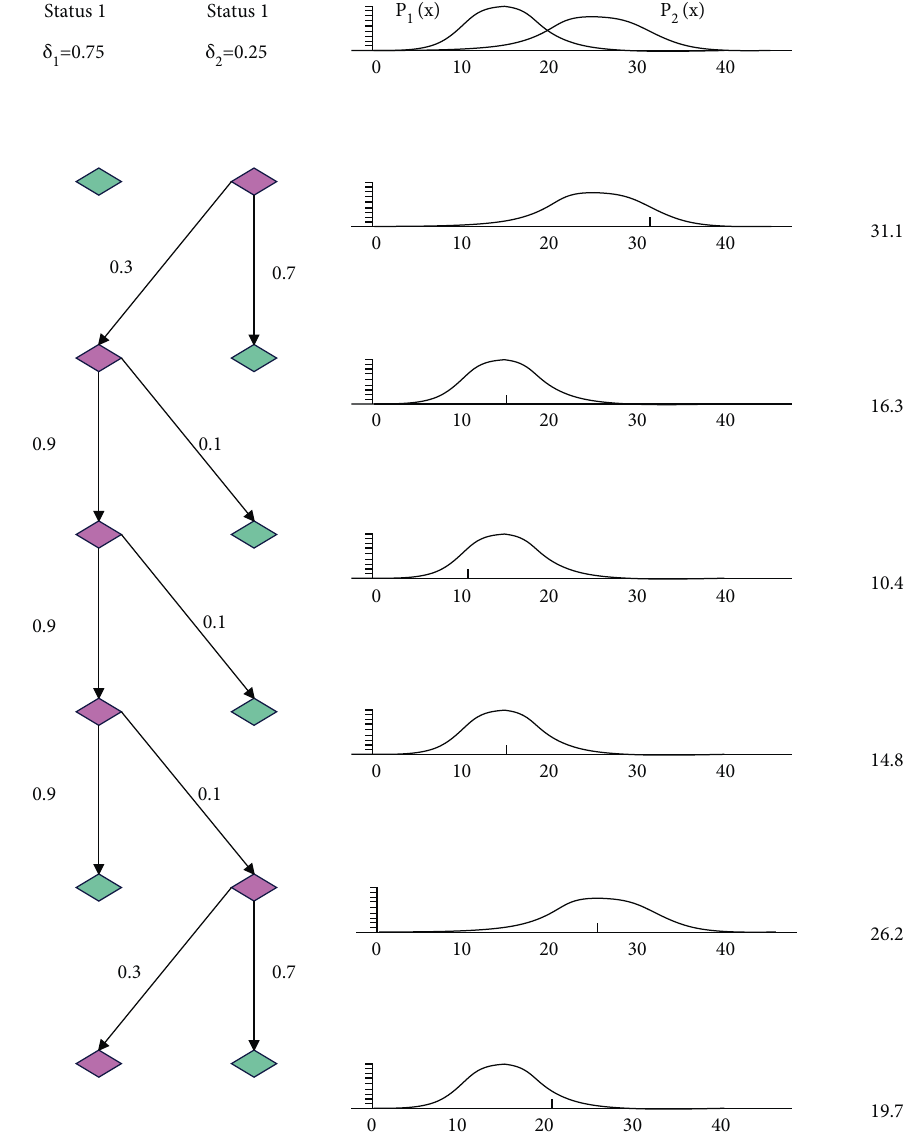
Figure 2: The generation process of the observation value of the 2-state hidden Markov